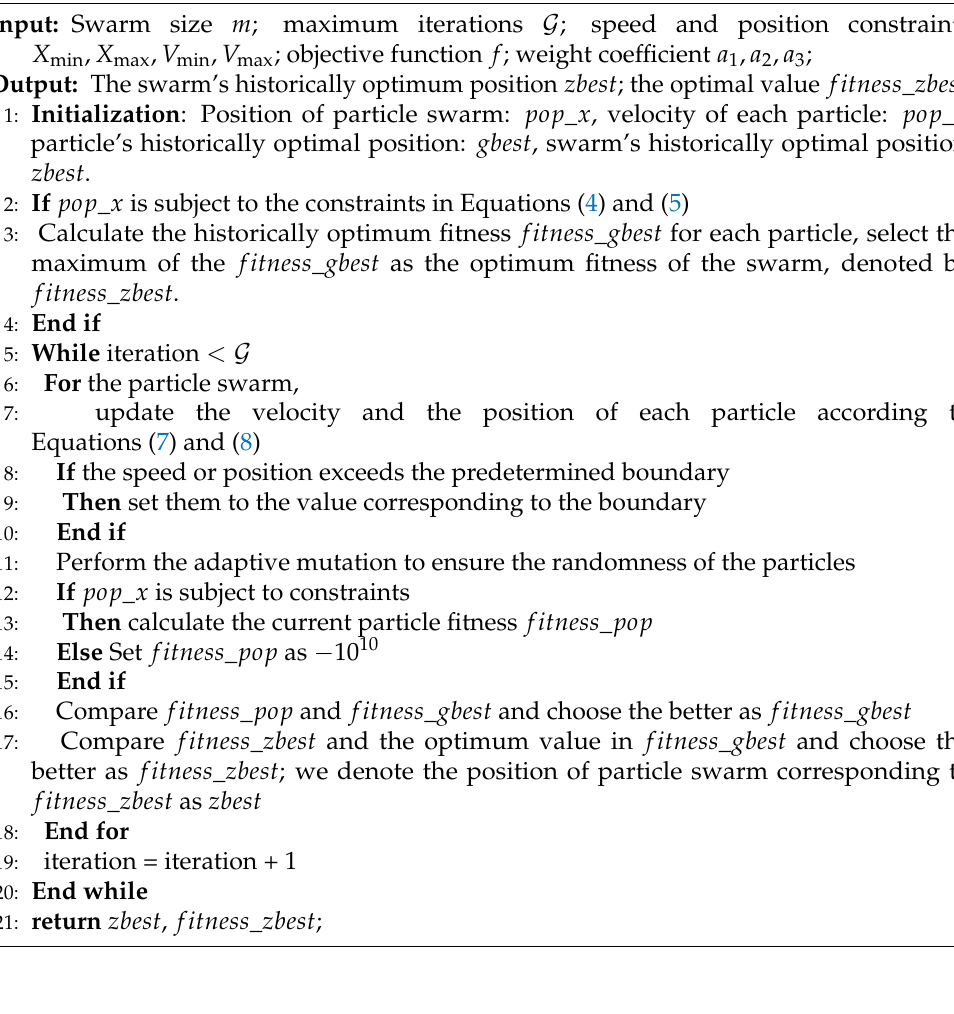
Algorithm 1 The PSO